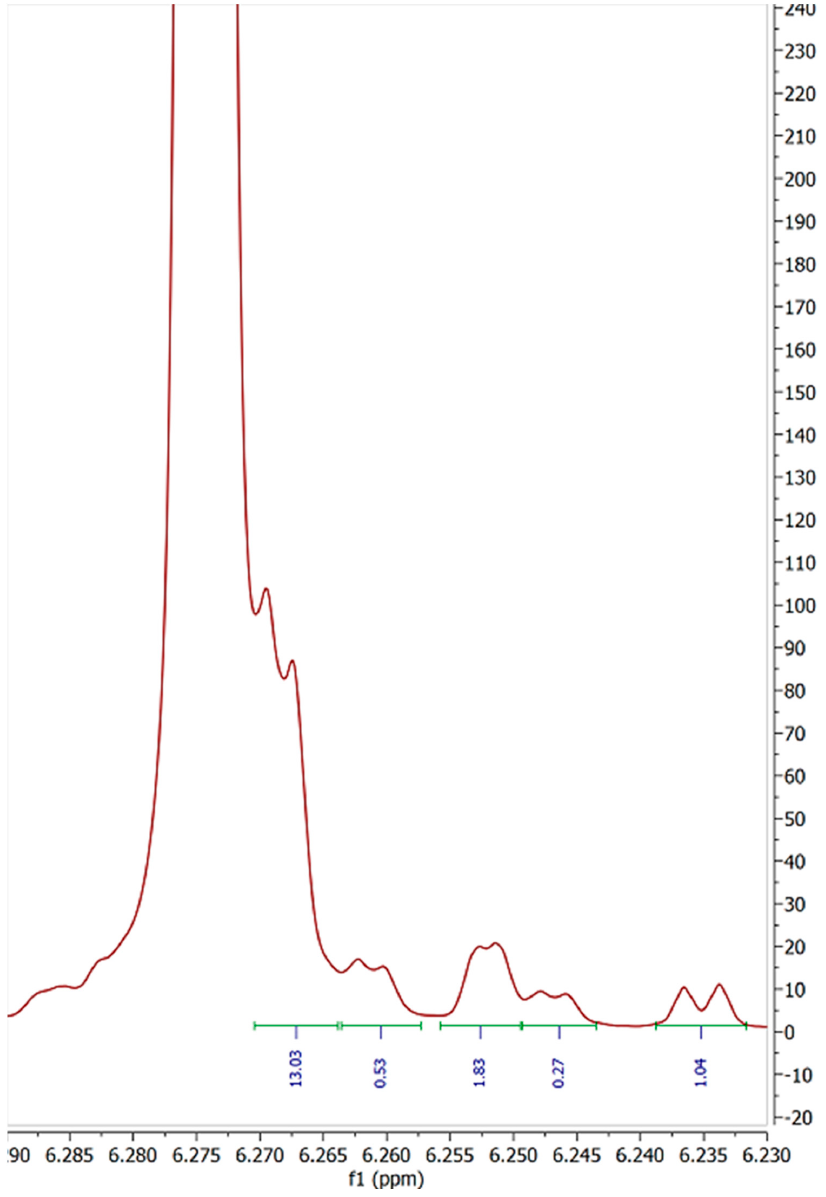
Figure 4. 6.23 to 6.29 ppm region detailing 5 ′ proton resonance of sample 3. (800 MHz, CDCl 3 ) δ 6.15 (d, J = 2.4 Hz), 6.26 (d, J = 1.6 Hz), 6.25 (d, J = 1.4 Hz), 6.24 (d, J = 2.2 Hz).